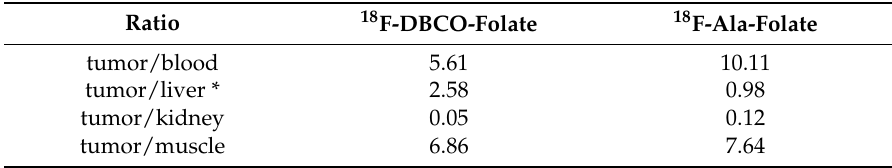
Table 4. Overview of different tumor to organ ratios for 18 F-DBCO-folate and 18 F-Ala-folate. Ratio 18 F-DBCO-Folate 18 F-Ala-Folate tumor/blood tumor/liver * tumor/kidney tumor/muscle